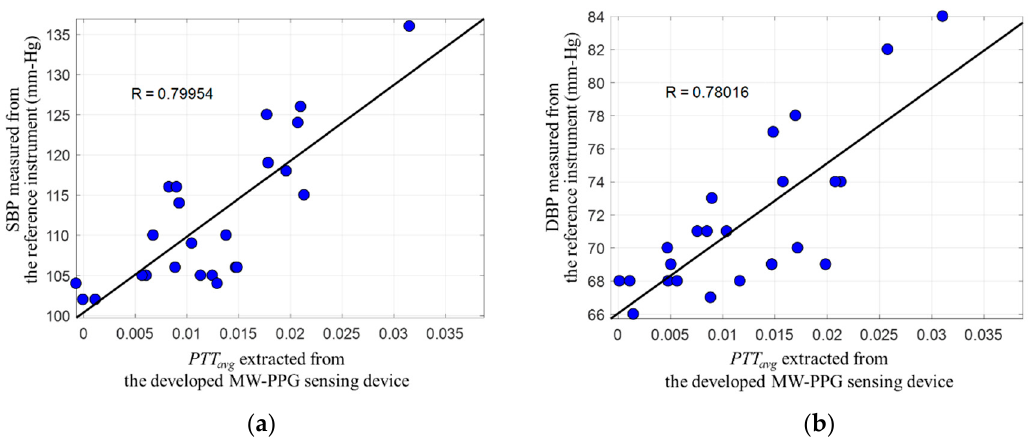
Figure 11. Correlation analysis between the blood pressure measured by the reference instrument against the PTT avg extracted from the developed MW-PPG sensing device: ( a ) systolic blood pressure (SBP); ( b ) diastolic blood pressure (DBP).